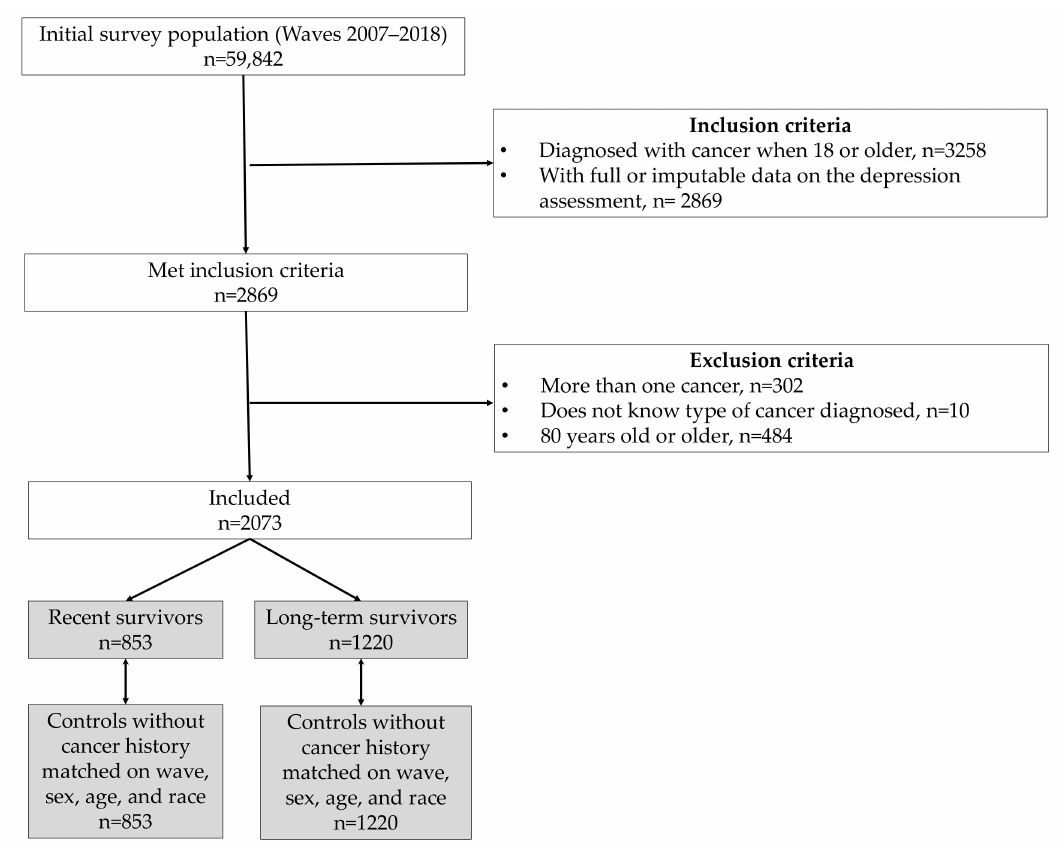
Figure 1. Flow chart describing the study sample selection